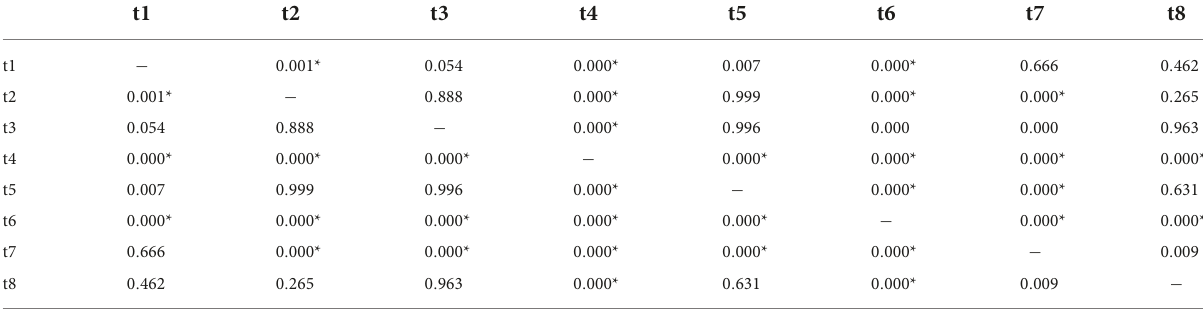
TABLE 9 Pairwise comparison of the treatments for NO by Scheffe post hoc test.